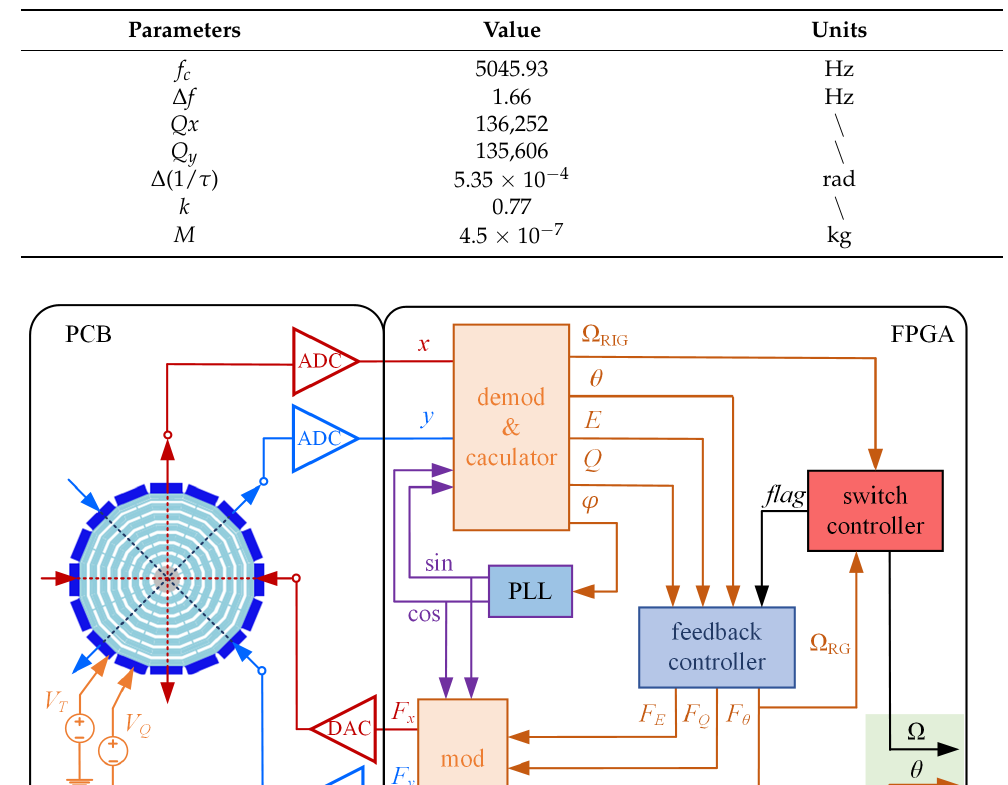
Table 2. Main parameters of the CDRG.